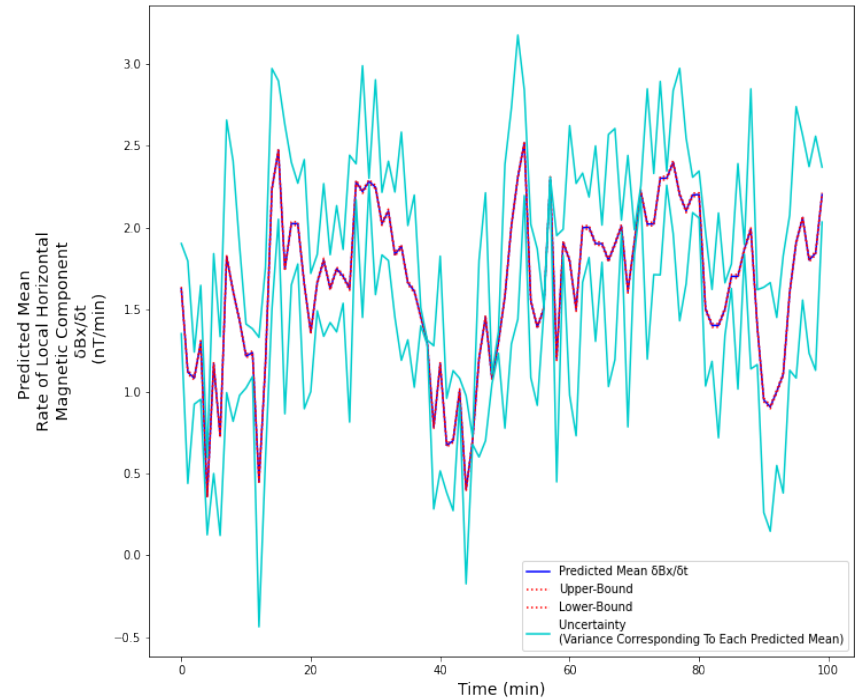
Figure 6. Predicted mean δ B x values for a set of test observations (from Ottawa, Canada), with 95% δ t confidence interval boundary and corresponding uncertainty (variance) for each predicted